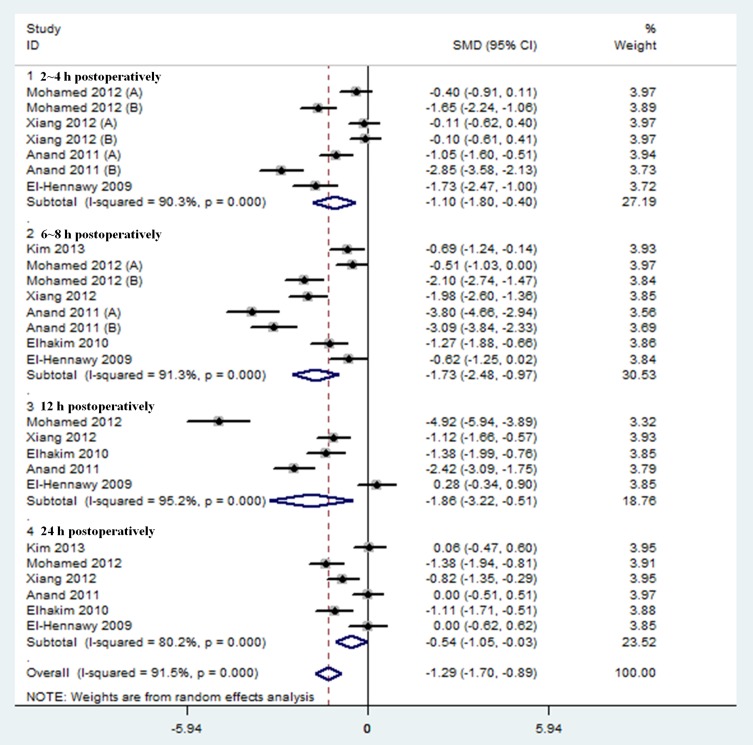
Forest plot: Postoperative pain intensity within 24 hours.